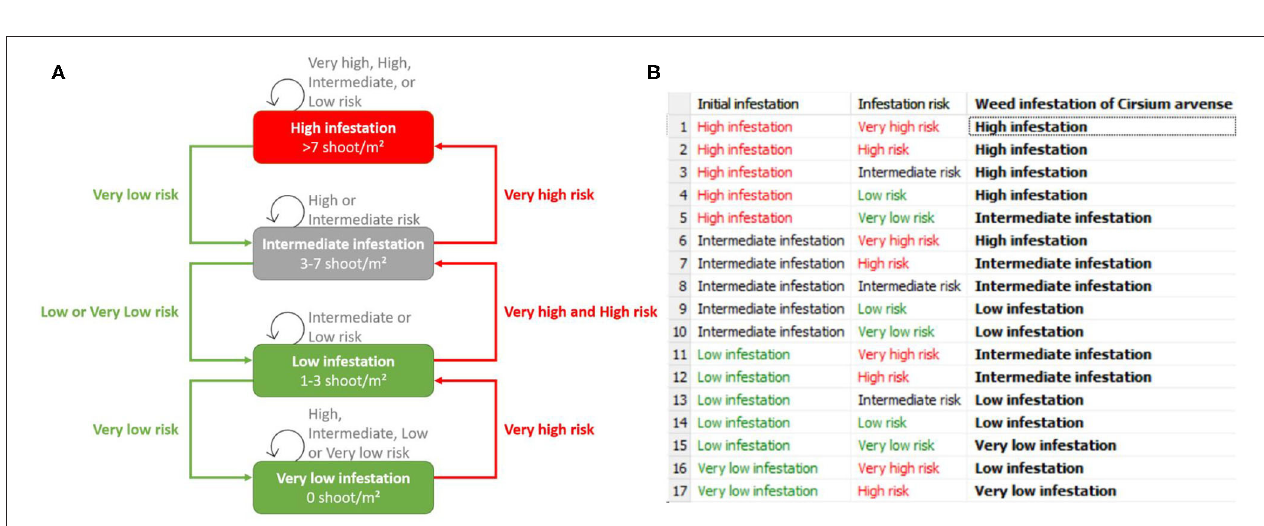
FIGURE 3 | Decision rules for final level of infestation (“Weed infestation of Cirsium arvense ”). Rules are designed according to the Initial level of infestation, represented in (A) by square labeled here as four-level scale : High infestation , Intermediate infestation , Low infestation , and Very low infestation (Green cells are beneficial for the field, Gray cell is neutral for the field and Red cell is detrimental for the field); and the Risk of infestation, represented by arrows, enabling to lower the infestation of C. arvense (Green downward arrows), increase the infestation (Red upward arrows), or maintain the same level of infestation (Gray circular arrows). (B) Represents the “Weed infestation of Cirsium arvense ” decision rules translated in the DEXi software (screenshot of the DEXi software) for the 20 possible combinations (four level of Initial infestation, five level of Infestation